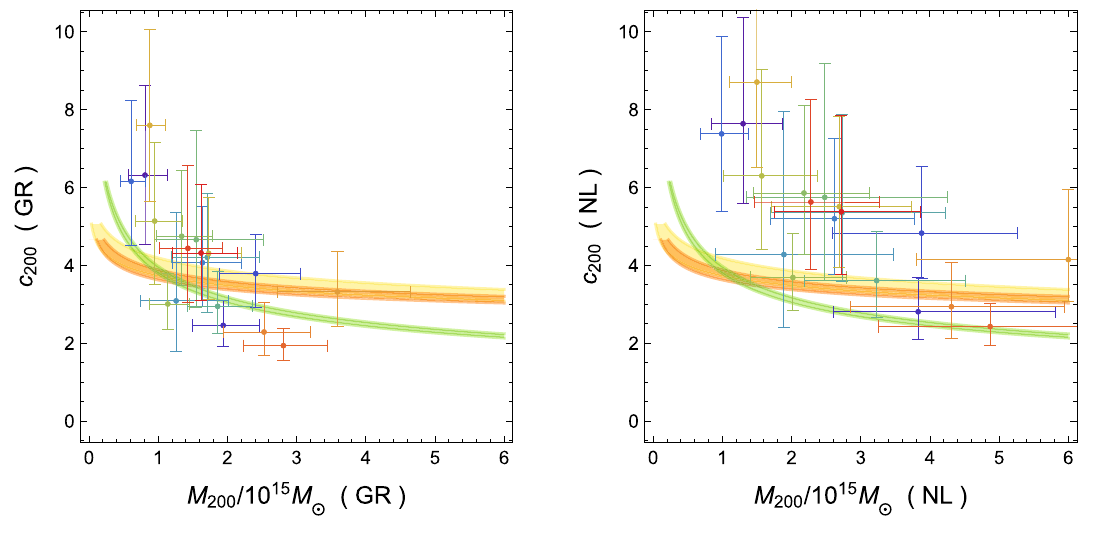
band: c – M relation for CLASH clusters derived by [75]. The upper and lower limits of the colored bands correspond to the minimum and maximum redshift values of CLASH